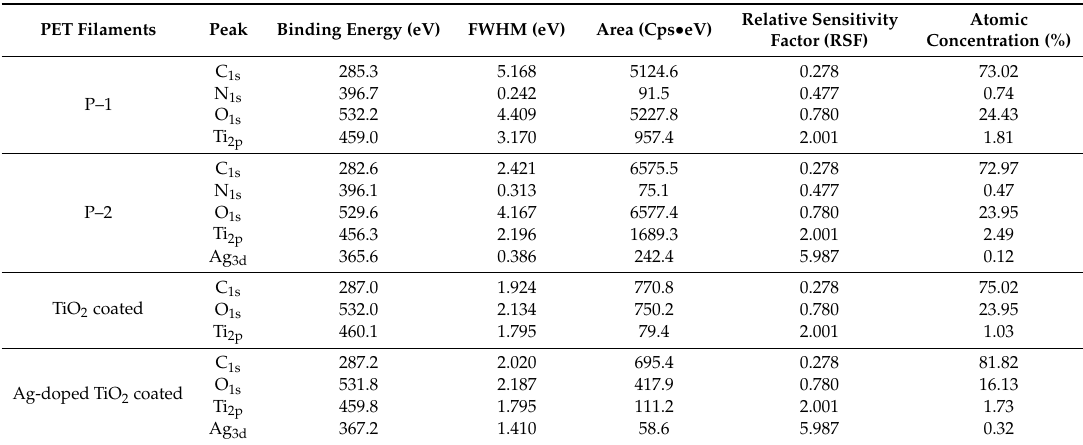
Relative Sensitivity Atomic Factor (RSF) Concentration